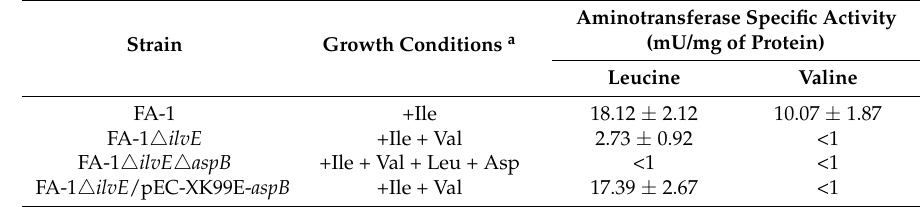
Figure 3. Comparison of the C. glutamicum strains FA-1 and FA-1 △ ilvE during cultivation in shake-flasks with fermentation medium. ( A ) C. glutamicum FA-1, ( B ) C. glutamicum FA-1 △ ilvE . Solid squares: OD 600 , Hollow circles: Glucose, Solid triangles: L -leucine, Hollow triangles: L -valine. The data represent mean values and standard deviations obtained from three independent cultivations. Table 1. Specific activities of transamination enzymes with leucine and valine as substrates.